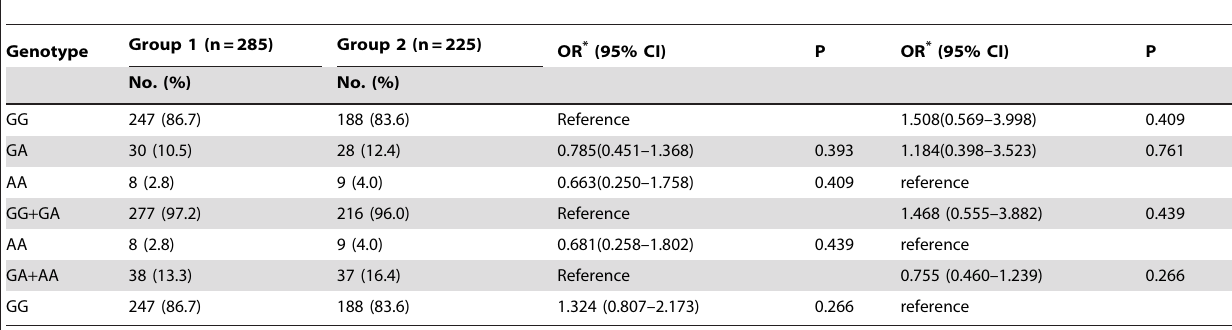
Table 5. ORs comparison between Group 1 (cervical cancer) and Group 2 (HPV positive without cervical cancer).